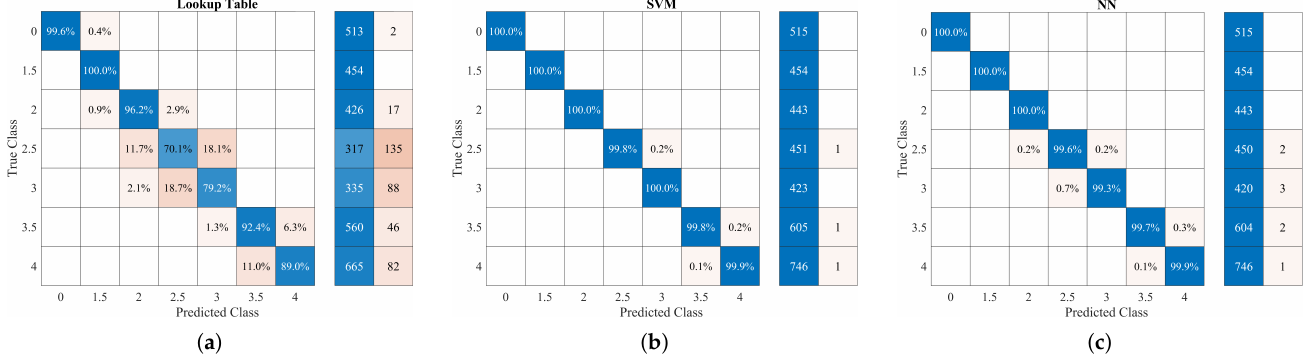
Figure 6. Confusion matrices resulting from the validation of the testing dataset of lookup table ( a ), SVM ( b ) and NN ( c )